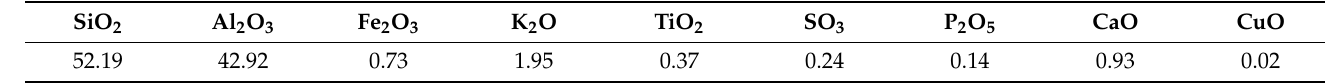
Table 1. Chemical composition of kaolinite